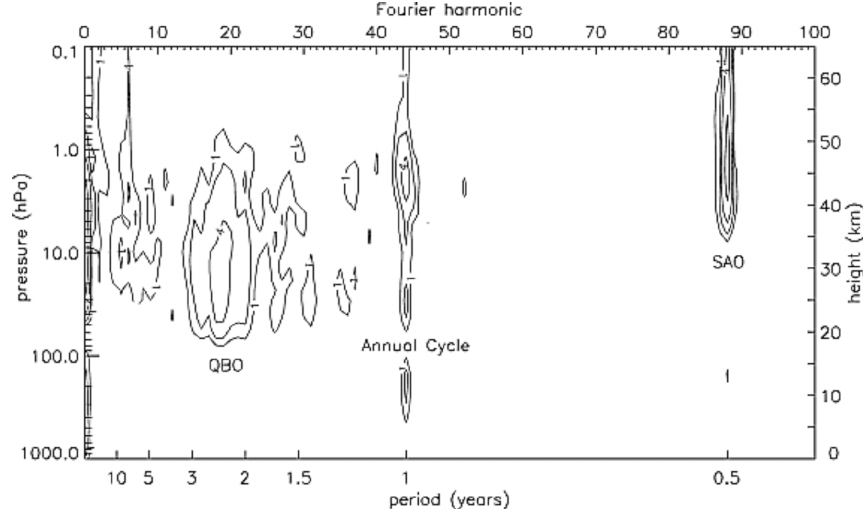
Figure 10. Periodogram (Fourier analysis) of equatorial zonal mean zonal wind for 44 years of reanalysis data from 1958 to 2001. The Fourier harmonic axis indicates the number of cycles that a given periodic mode experienced during the 44 years. The periods of some Fourier harmonics are also indicated. Contours are drawn at Fourier amplitudes of 1, 2, 4, 8 and 16ms − 1 . Figure 3 from Pascoe et al. (2005). ©American Geophysical